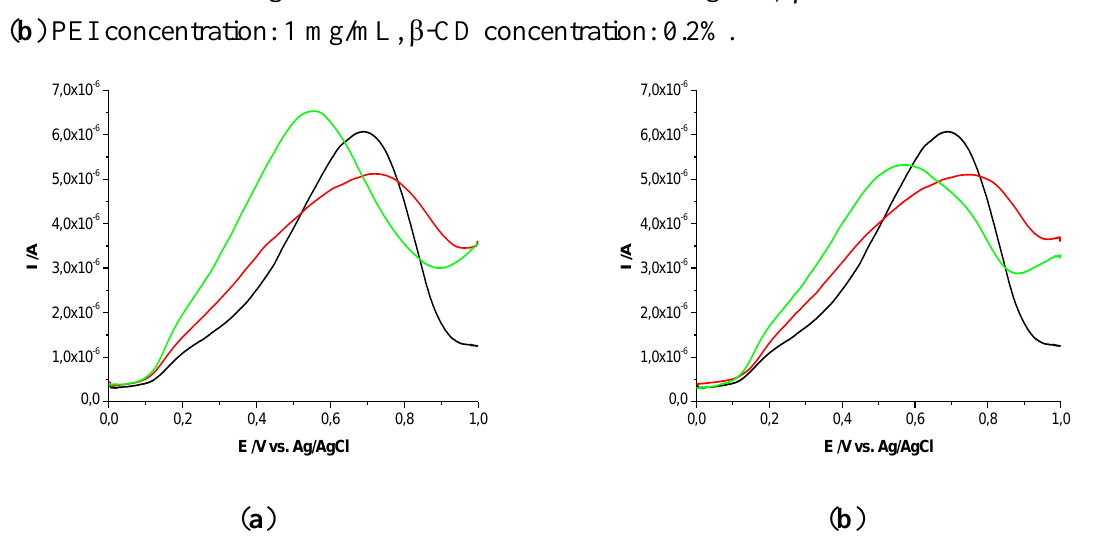
Figure 1. SWVs of UA 10 −3 M in PBS (0.1 M; pH 7.2) on bare GCE (black); GCE+PEI (red); GCE + PEI + CD (green) ( a ) PEI concentration: 5 mg/mL, β-CD concentration: 1%; ( b ) PEI concentration: 1 mg/mL, β-CD concentration: 0.2%.